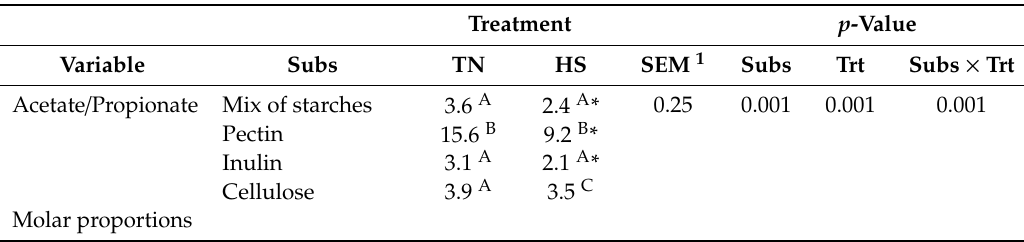
Table 3. Acetate:propionate ratio and molar proportions of short-chain fatty acids after 24 h in vitro fermentation of four substrates (Subs) by fecal inocula obtained from pigs under thermoneutral (TN) or heat stress (HS)